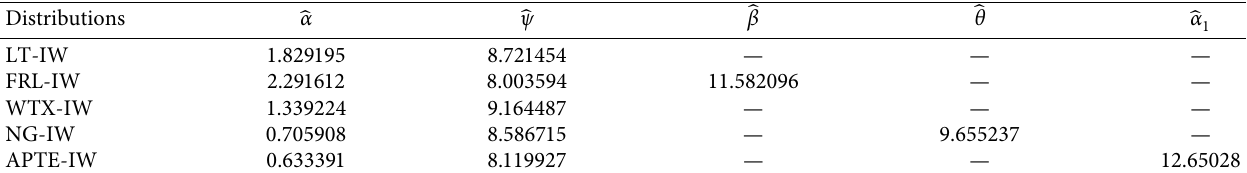
Figure 6: Some summary plots of the COVID-19 data set. Table 1: The values of the maximum likelihood estimators of the fitted models using the COVID-19 data set.